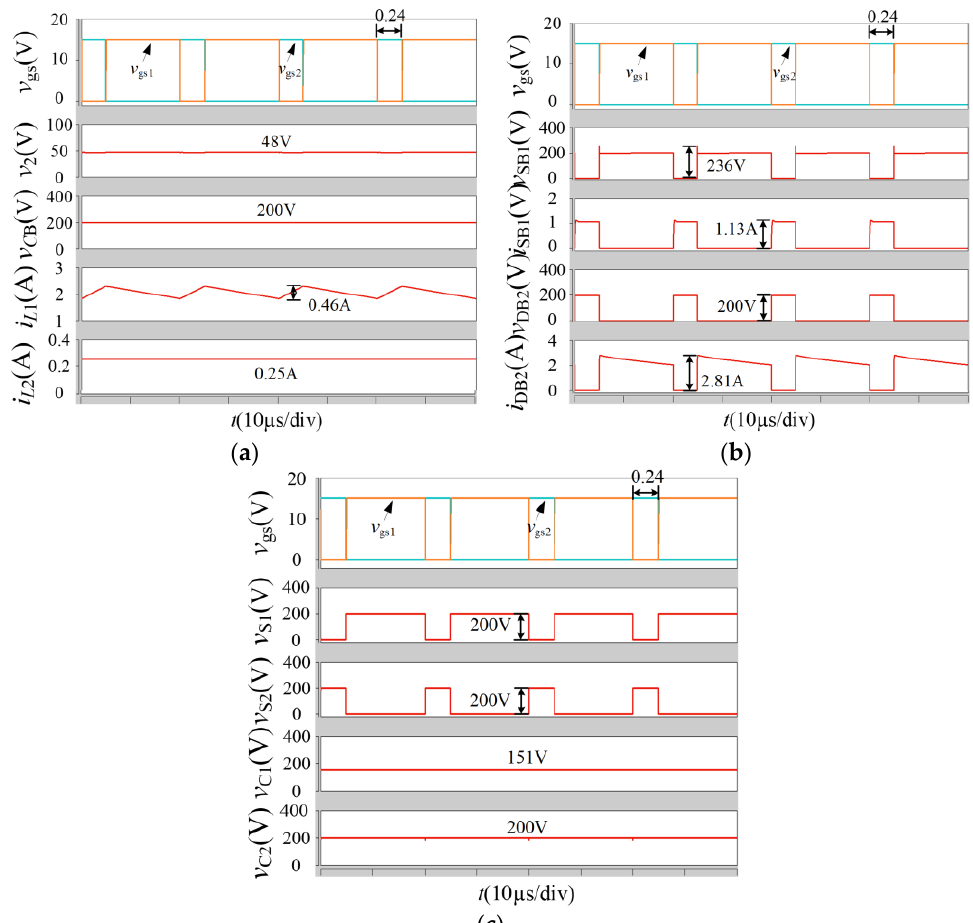
Figure 9. The steady waveforms in step-down mode ( V 1 = 400 V): ( a ) v gs1 , v gs2 , v 2 , v CB , i L1 , i L2 ; ( b ) v gs1 , v gs2 , v SB1 , i SB1 , v DB2 , i DB2 ; ( c ) v gs1 , v gs2 , v S1 , v S2 , v C1 v C2 .